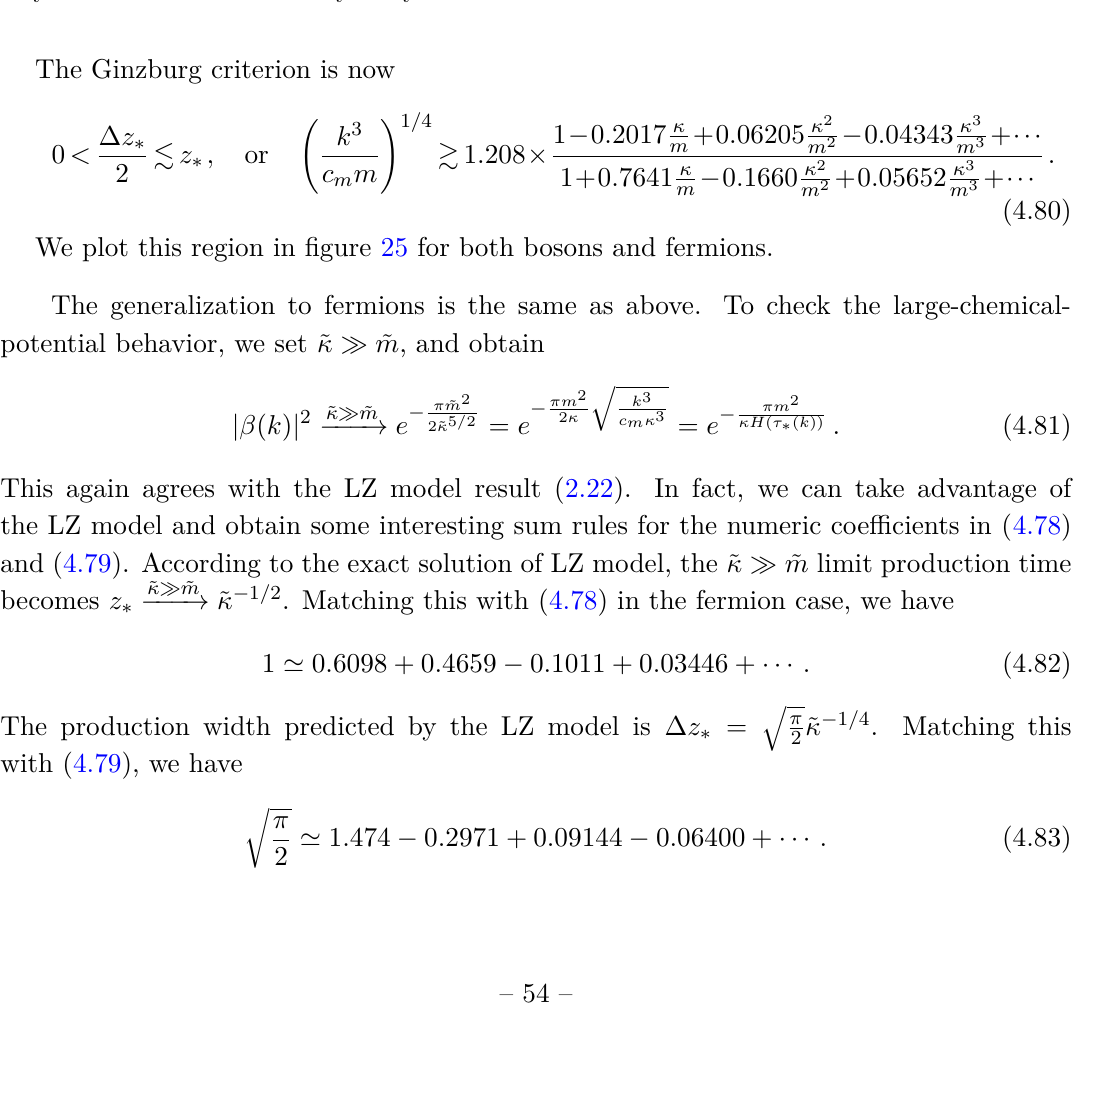
Figure 24 . The Stokes lines for spin-1 bosons (left panel) and spin-1/2 fermions (right panel) in matter-dominated universe. In both panels, the mass is set to ˜ m = 0 . 1 , and the momentum k is fixed to have a dimensionless chemical potential ranging over ˜ κ = − 0 . 08 , − 0 . 06 , · · · , 0 . 06 , 0 . 08 (from left to right, and the green lines correspond to the case without chemical potential). The gray region with Re z < 0 cannot be reached physically. Solid lines represent scenarios where the Ginzburg criterion (4.80) is fulfilled and vacuum initial condition is satisfied, while dotted lines can only be understood in the analytically continued